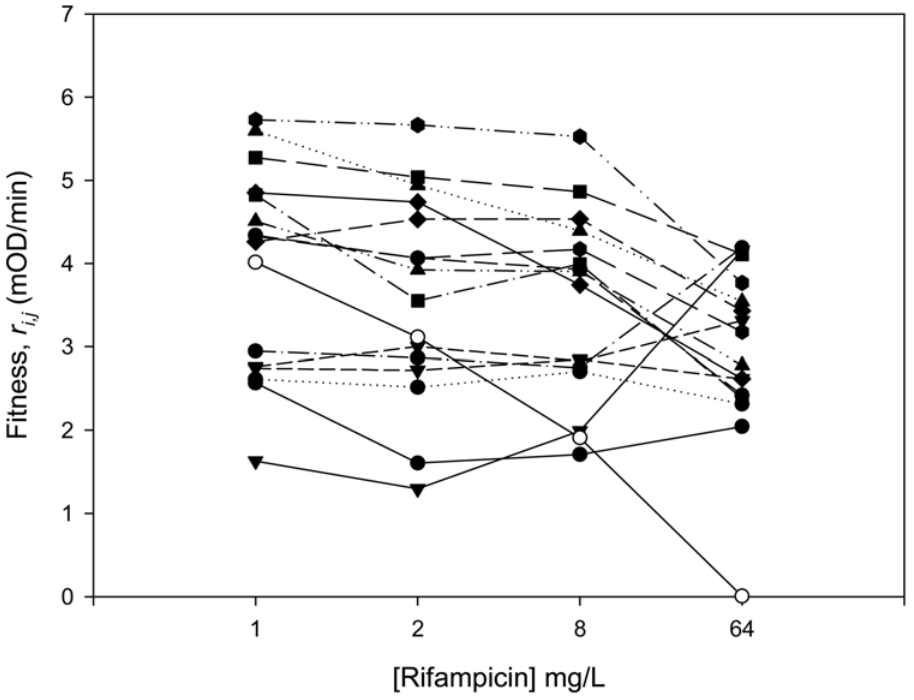
Figure 2. Fitness effects of beneficial mutations. Plotted points show the fitness, r , of the wild-type (open symbol) and beneficial mutations (filled symbols) at different concentrations of rifampicin. Fitness was estimated as the mean growth rate of 12 to 18 cultures of each strain at each concentration of rifampicin (standard errors not shown).